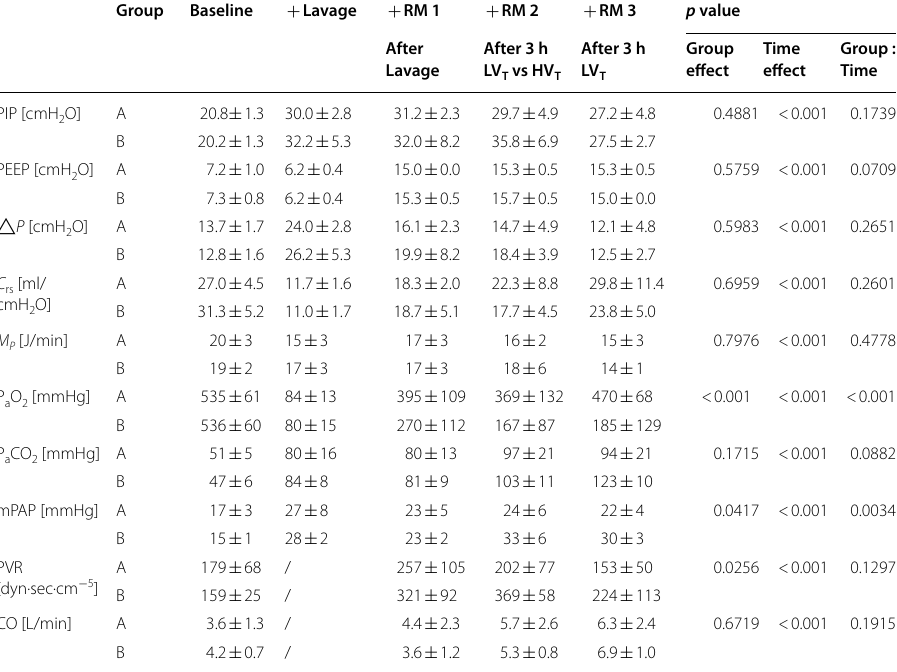
Table 1 Respiratory and hemodynamic